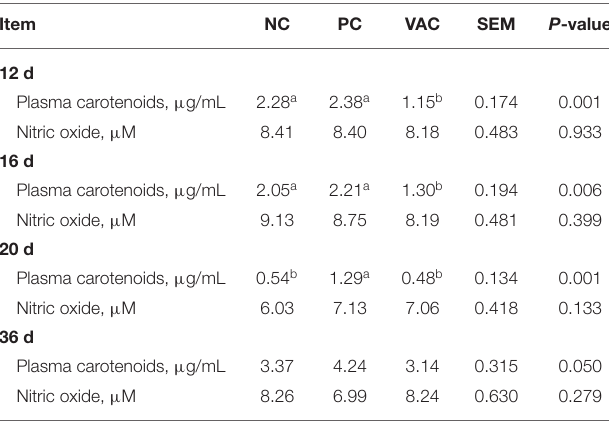
Plasma carotenoids, µ